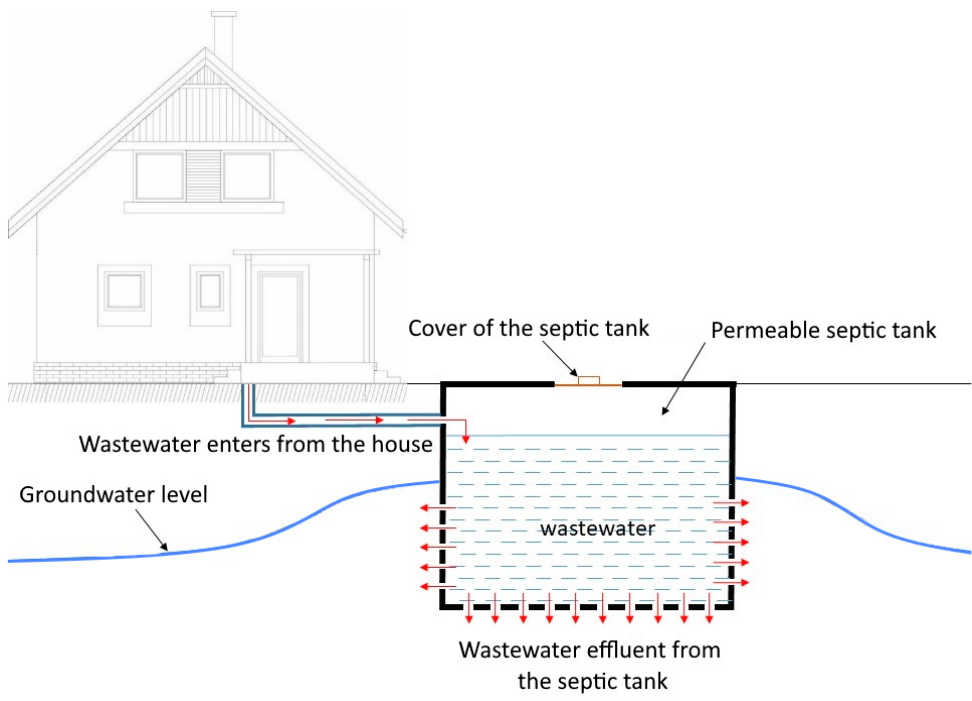
Figure 2. Schematic illustration of permeable constructed septic tanks in Hungary.